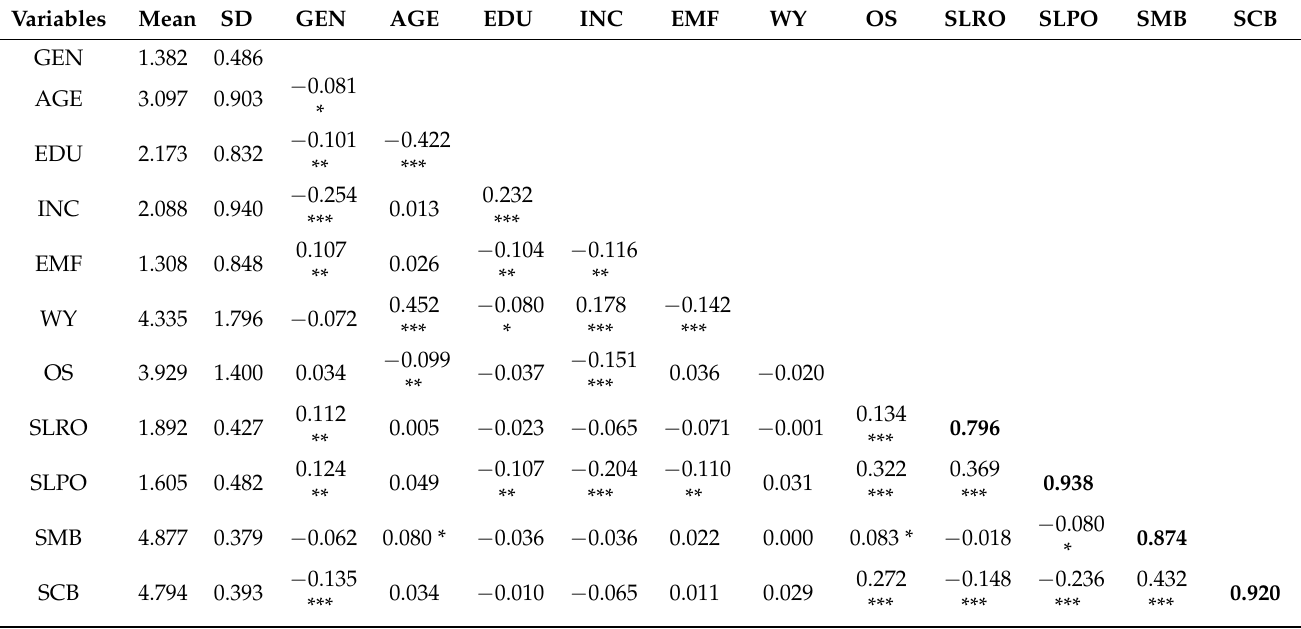
Table 2. Means, SD, correlation coefficients of all variables and square root of AVE values of all constructs.